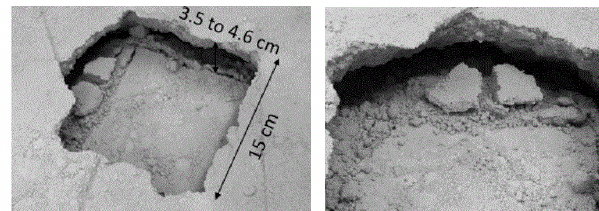
Figure 12. Collapsed zones of the cohesive soil layer following a surface loading.